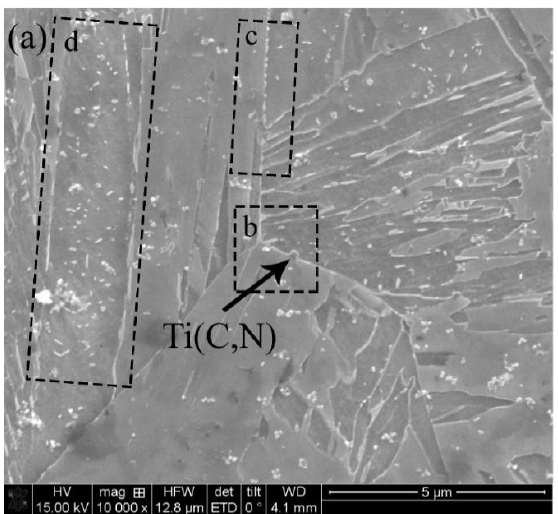
Figure 7. SEM pictures of S(640, 50) displays secondary precipitates at different size and shapes.